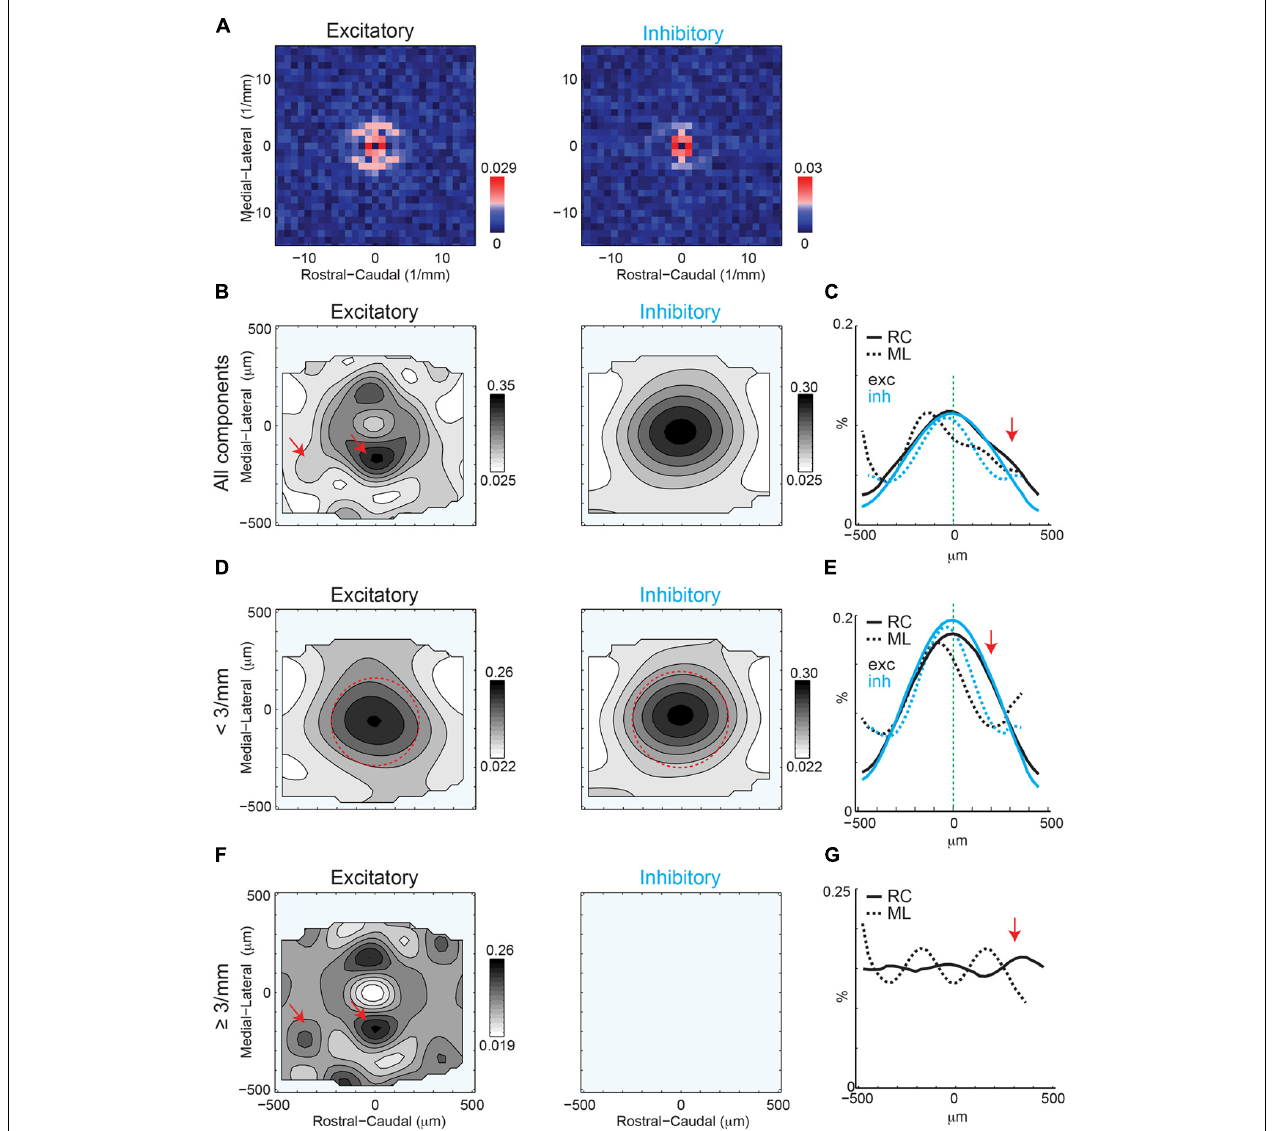
FIGURE 6 | (A) 2D Fourier transforms of the mean connection probability maps demonstrate anisotropy of significant spatial frequency components along the ML (isofrequency) for excitatory inputs but relative symmetry of significant spatial frequency for inhibitory inputs. Red pixels indicate significant components ( p < 0.05, bootstrap test). (B) Reconstruction of spatial maps using only the significant frequency components (red pixels in A ). Red arrows show anisotropic patches at different orientations and distances. (C) Marginals in the RC and ML direction. Note that RC marginal are wider than ML marginal (arrow). Full width at half max for excitation: ML